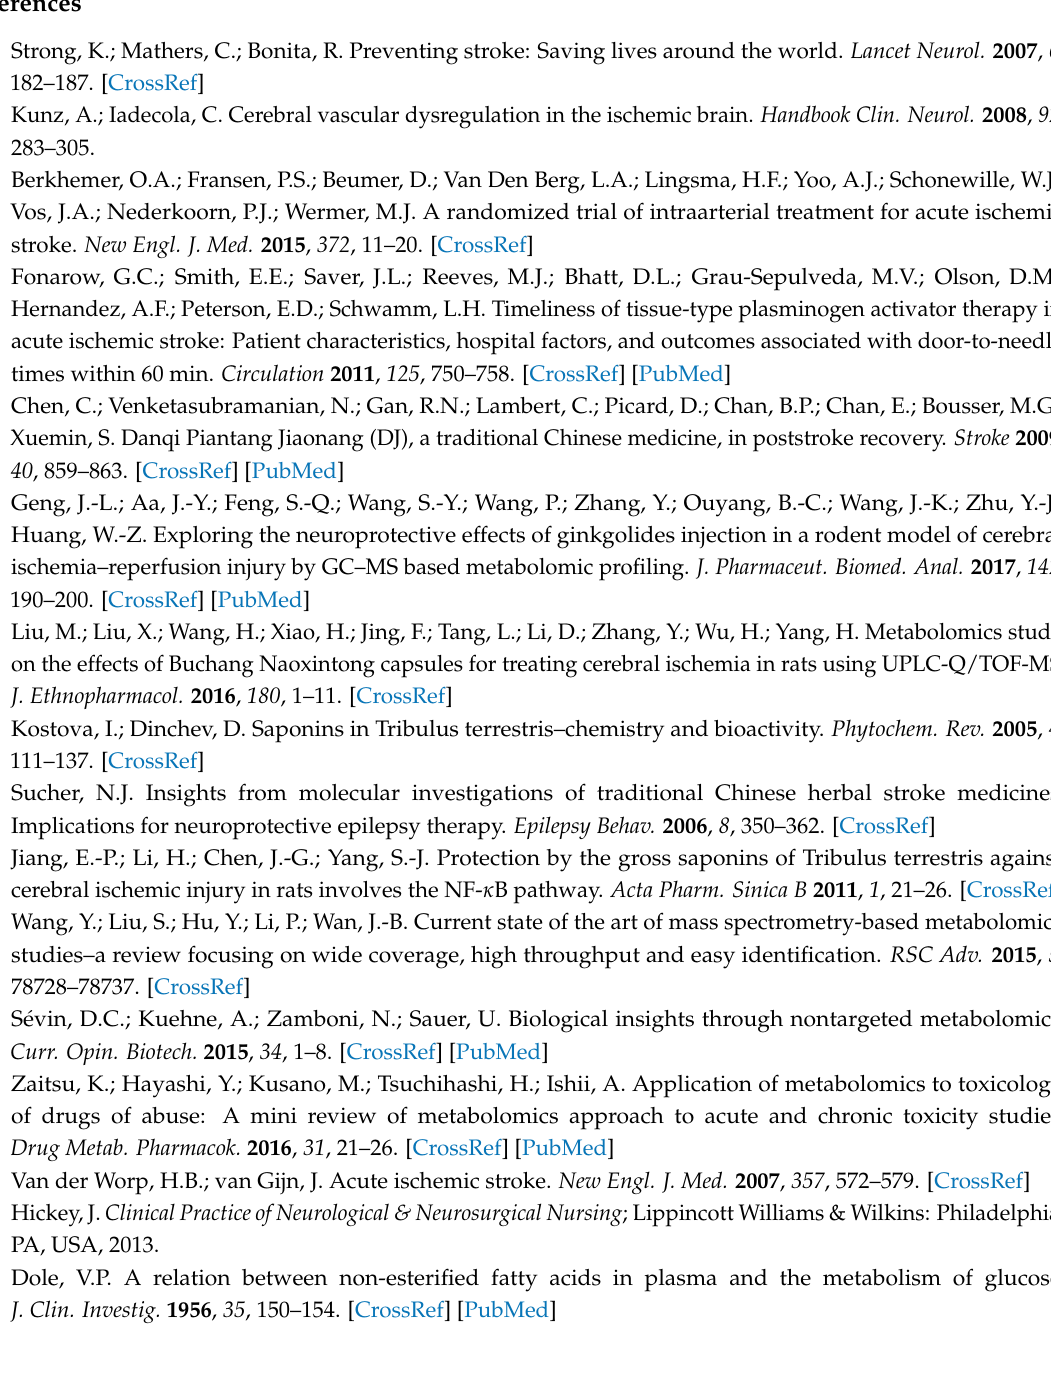
Supplementary Materials: The following are available online, Figure S1: The typical GC-MS TIC of serum samples, Figure S2: Representative mass spectra of the detected metabolite, Table S1: The detailed information of the selected